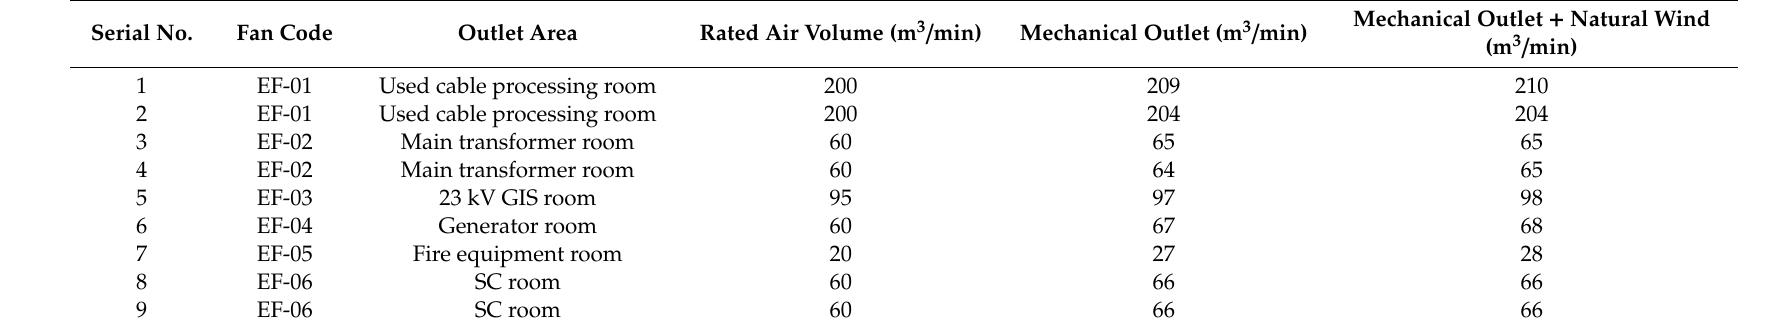
Table 9. Outlet volume simulation